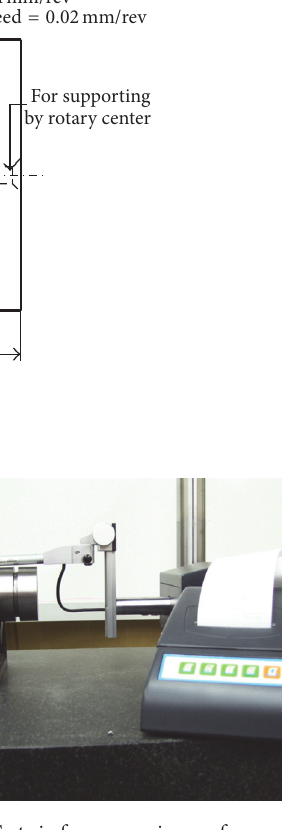
Figure 3: Test rig for measuring surface